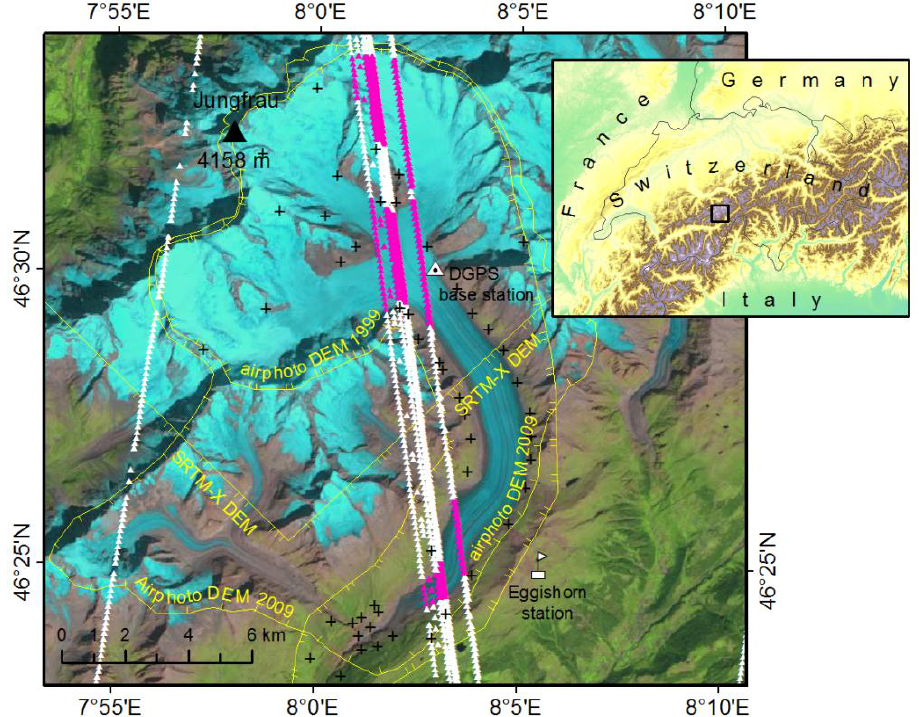
Figure 1. Ground tracks of ICESat cross the surface of Grosser Aletschgletscher in three separate places: Ewig Schneefeld (A1), Konkordiaplatz (A2) and the lower part close to the terminus (A3). ICESat measurements on the glacier are highlighted in violet. Outlines of the DEMs with only partial coverage of the area are in yellow. The points used as ground control for the airphoto DEMs are shown as black crosses. In the background is a Landsat TM image from 28 August